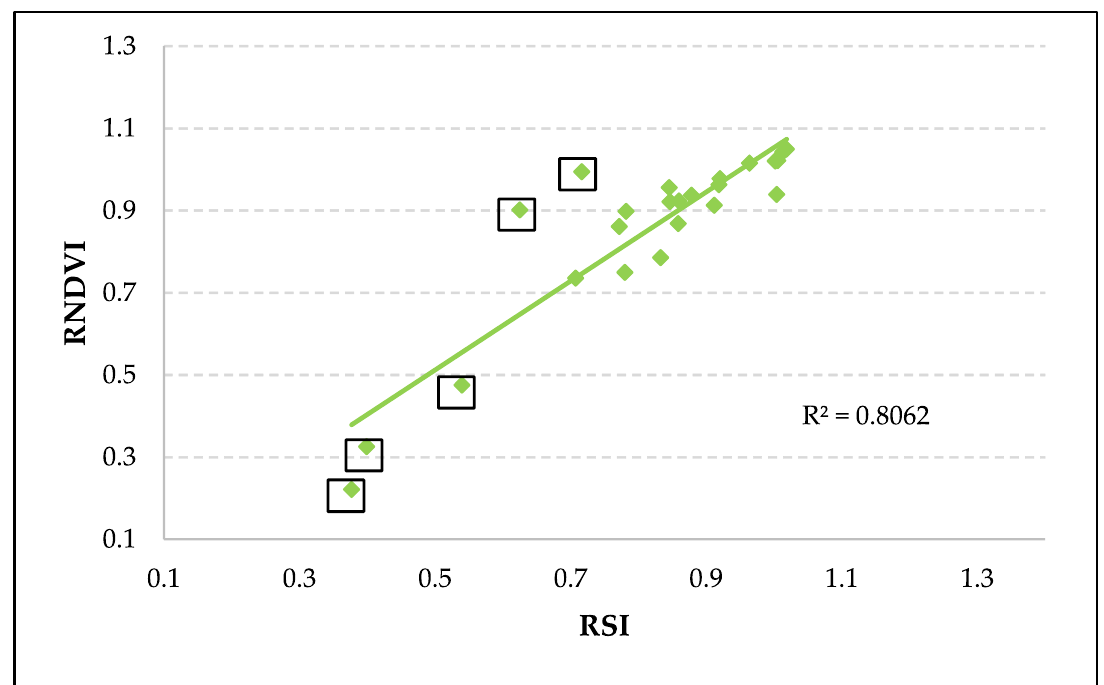
Figure 4. The relationship between relative SPAD index (RSI) and relative normalized difference vegetation index (RNDVI) of 12 wheat varieties cultivated under three N levels. The points marked with a square box show deviation of the varieties from the regression trend line.